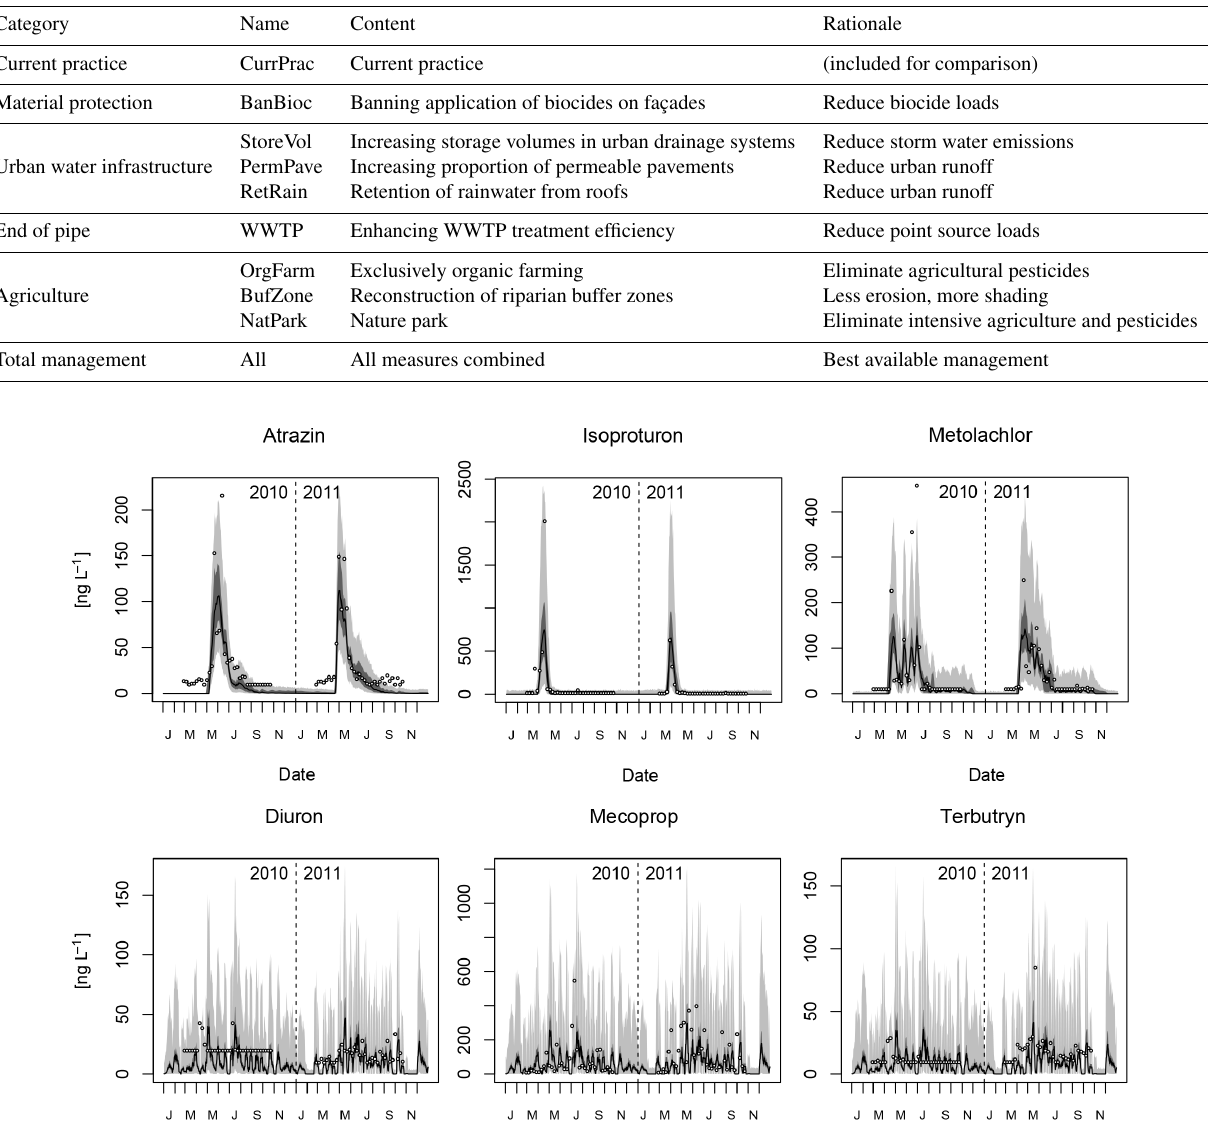
Figure 3. Calibration performance for selected micropollutants (top row: PPPs; bottom row: biocides). Dots are observations, black line is the model simulation with maximum posterior probability parameters, and the grey region is the 95% uncertainty interval. All values are weekly mean concentrations; detection limits were 10ngL − 1 for all observations. PPPs not featured here are shown in Sect.